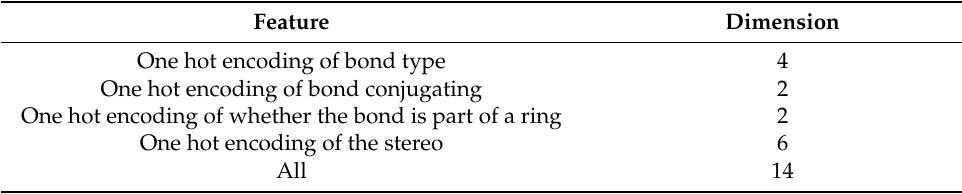
Table 3. Input data representations: Compound bond features.